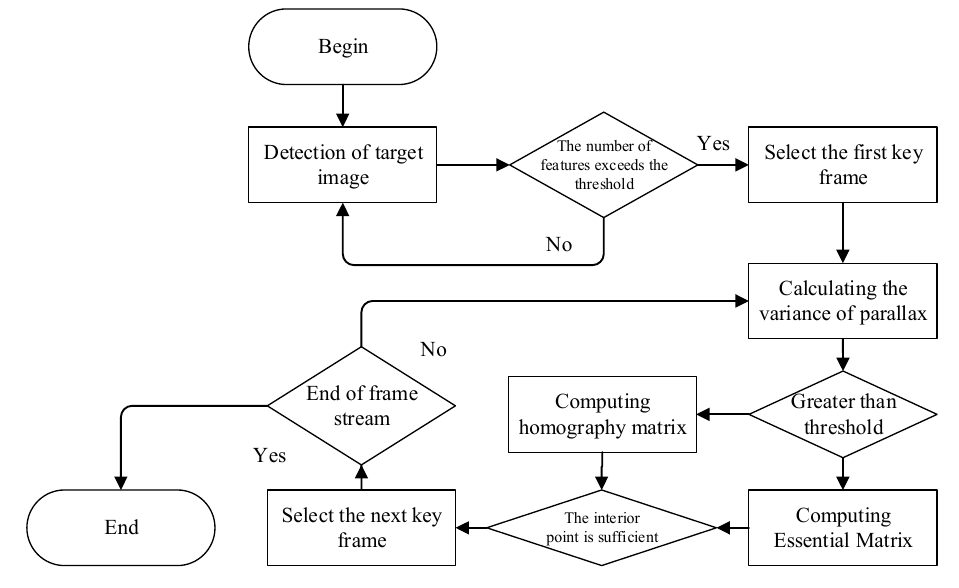
Figure 15. Keyframe extraction process.